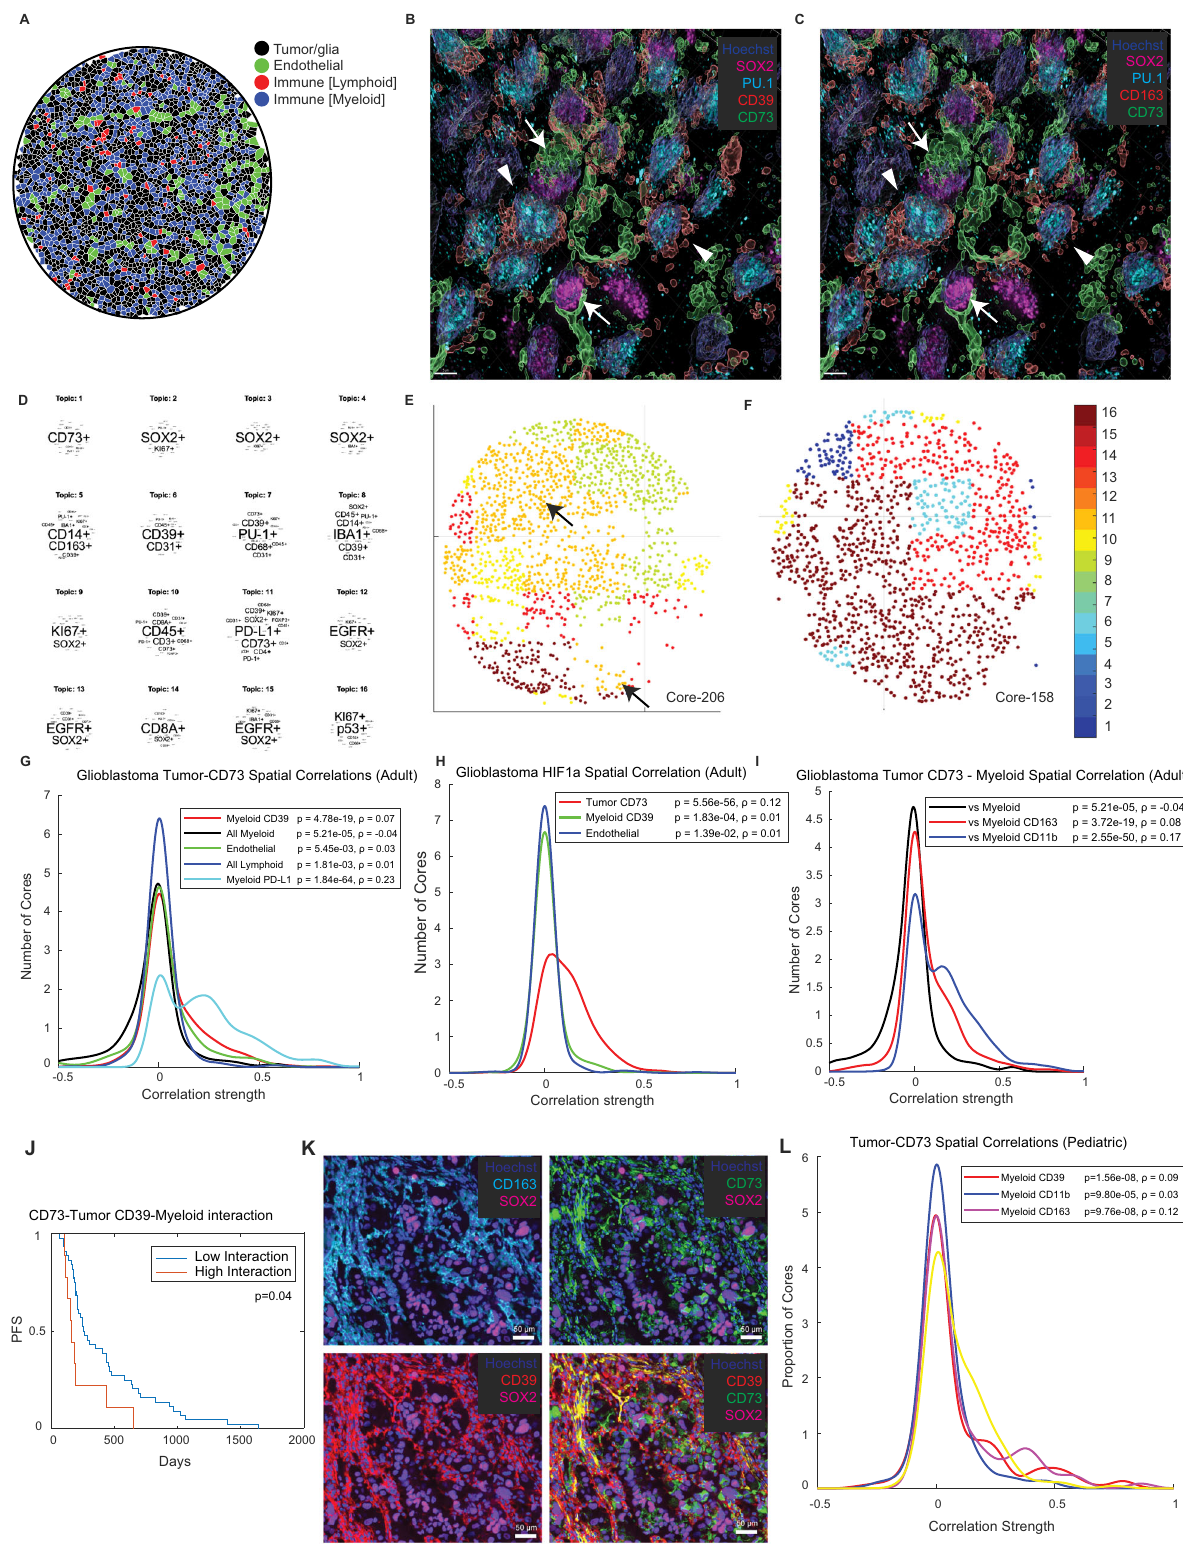
Single-cell RNA-Seq analysis Single-cell analyses of a cohort of 28 adult and pediatric high-grade gliomas in Figs. 1 and 2A – C, and Fig. S1 were performed using the data from a previously published study (Neftel et al. 2019) 41